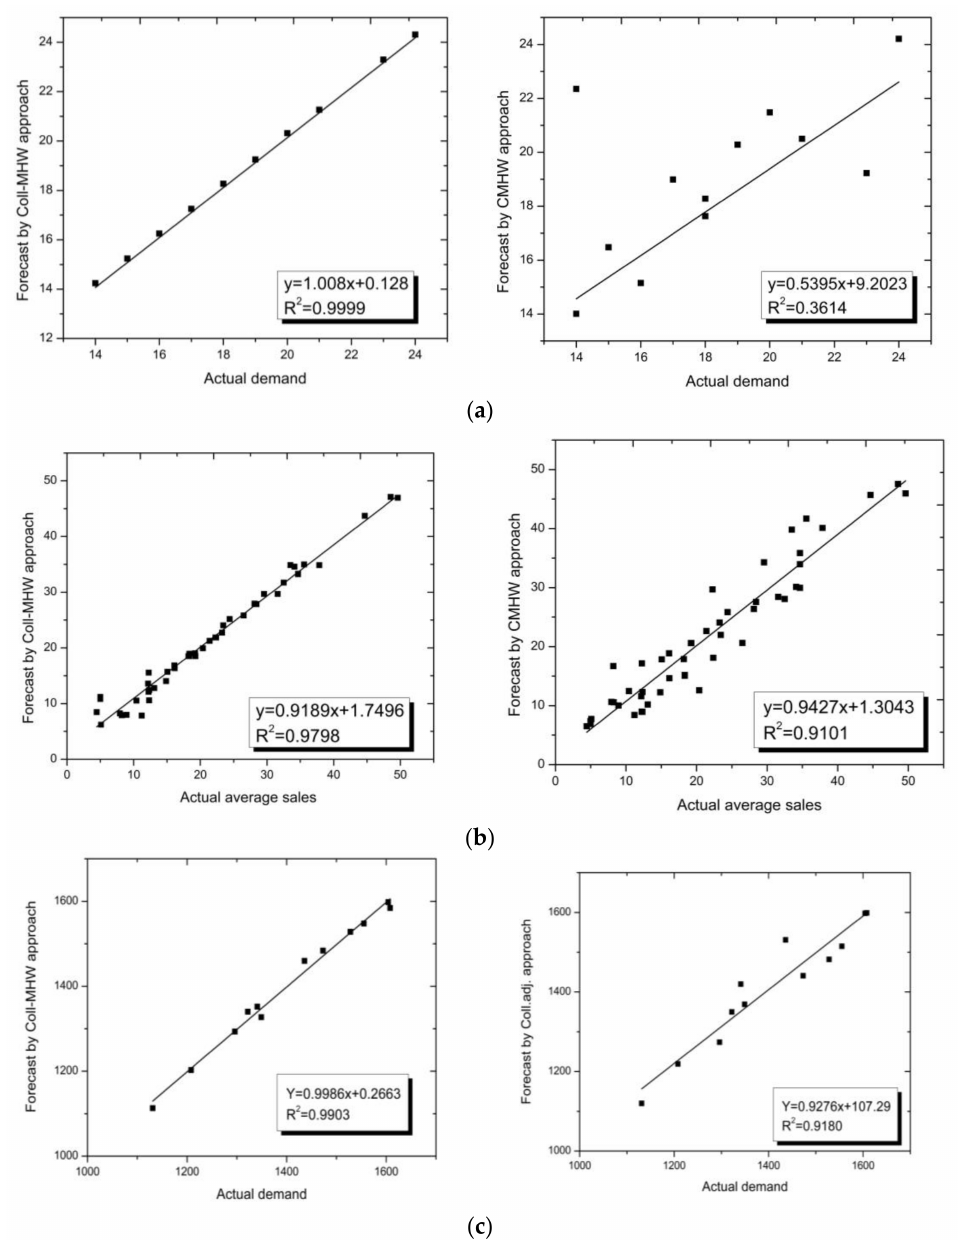
Figure 12. Correlations between actual and forecasted data for ( a ) Case-1; ( b ) Case-2; ( c )